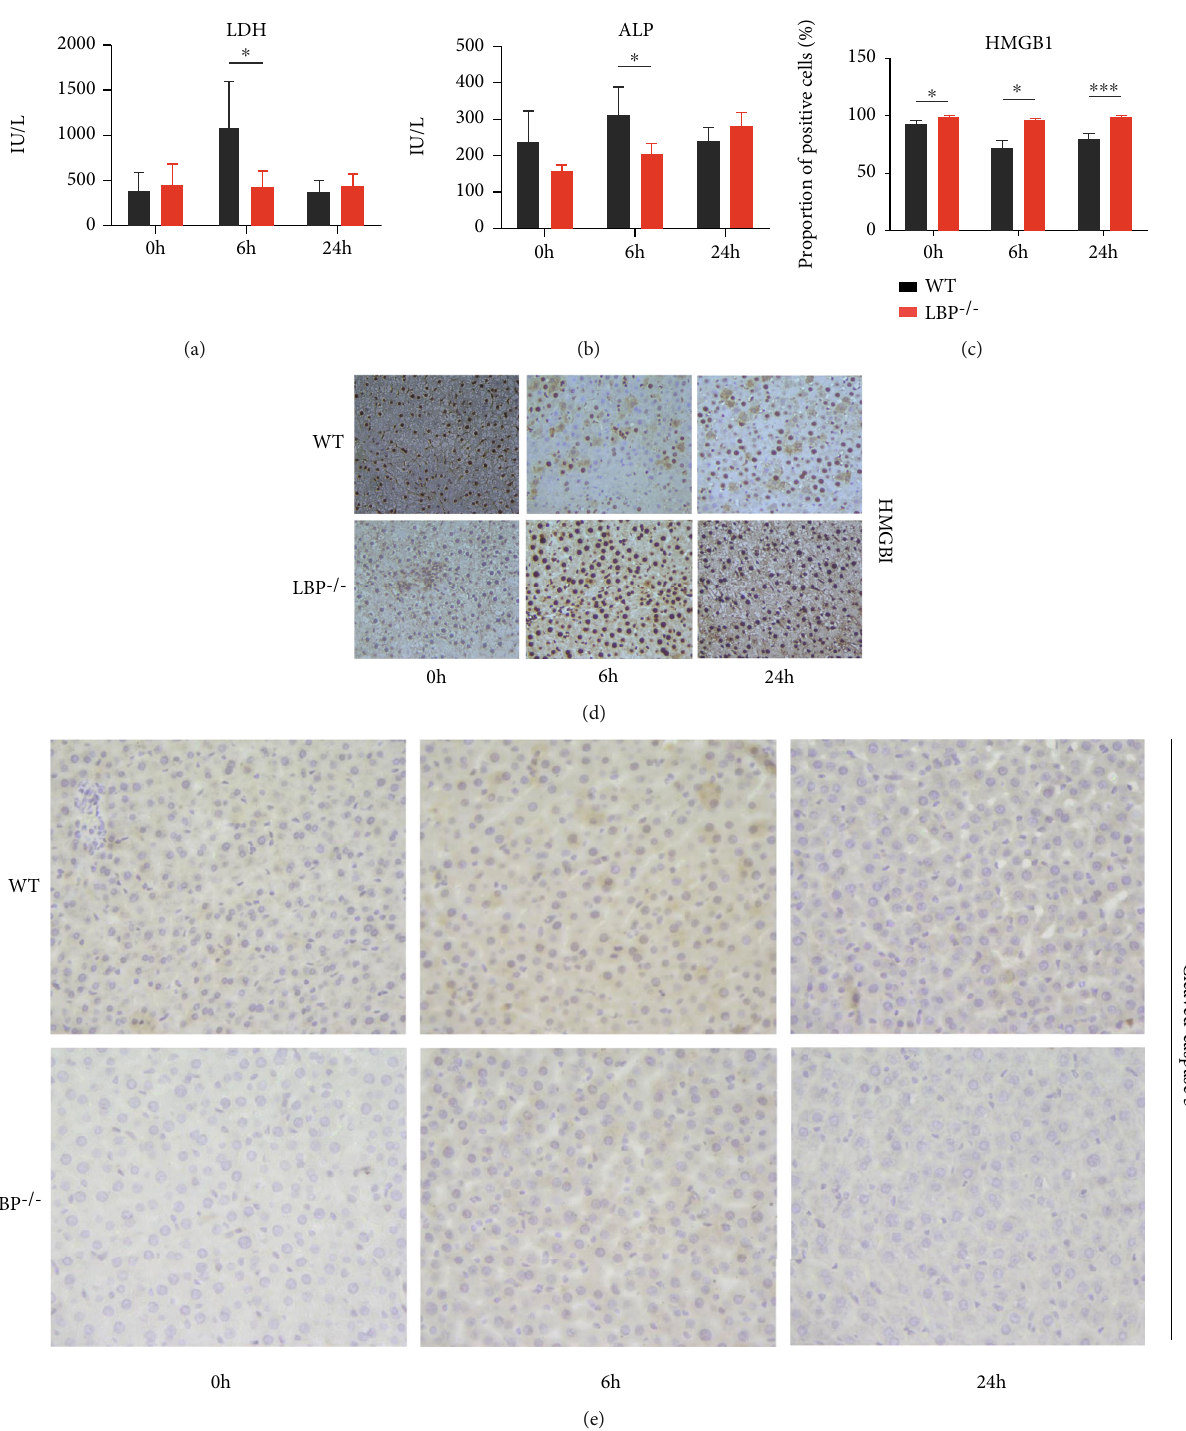
Figure 6: Expression levels of in fl ammatory indicators in wild-type and LBP-de fi cient groups after LPS injection. (a, b) Levels of liver enzymes of LDH (a) and ALP (b) levels in serum samples collected at 0 h, 6 h, and 24 h after LPS challenge. Serum LDH and ALP levels were analyzed as a measure of hepatocellular injury. Data are shown as means and standard deviations ( n = 3 per group at each time point). (c) The percentage of hepatocytes with only nucleus HMGB1 staining out of the total number of hepatocytes was calculated. Data were shown as the mean ± SD . (d) HMGB1 cellular location of liver tissues in the normal rats and LBP -/- rats at 0 h, 6 h, and 24 h after LPS administration. Original magni fi cation × 400. (e) The expression levels of cleaved-caspase 3 in the wild and LBP -/- rats at multiple time points after liver LPS injection were assessed using IHC. Original magni fi cation × 400. ∗ P < 0 : 05 , ∗∗ P < 0 : 01 , and ∗∗∗ P < 0 : 001 vs. wild type, signi fi cantly di ff erent from the wild-type